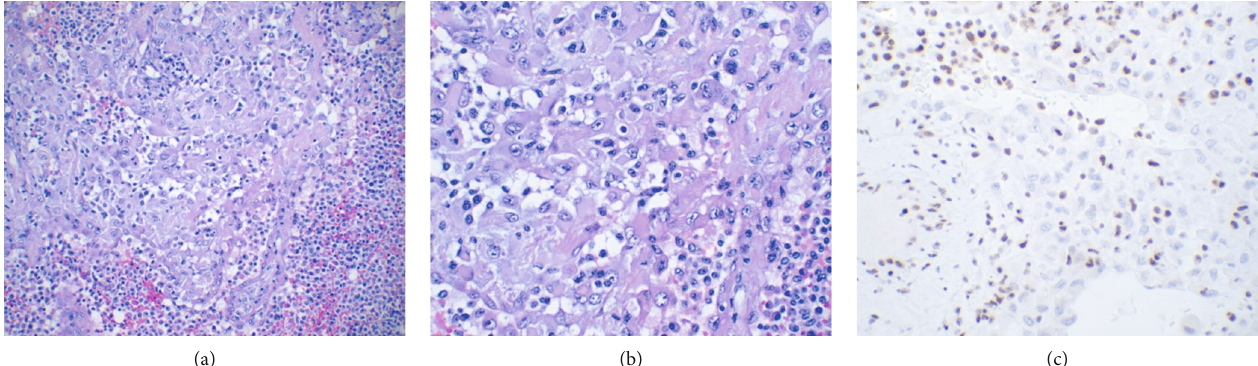
Figure 3: Immunohistochemical fi ndings postresection. (a) Malignant epithelioid cells with moderate eosinophilic cytoplasm and rhabdoid features along with prominent lymphoid in fi ltrate (200x). (b) Higher magni fi cation (400x). (c) Loss of INI-1 stain in neoplastic cells; background in fl ammatory cells stained positive with